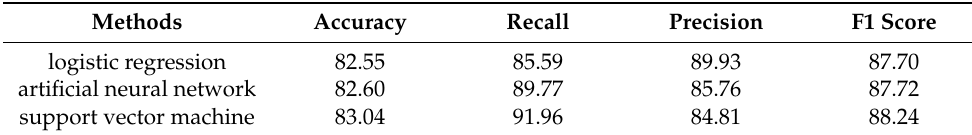
Table 3. Performance comparison of models on test data set.